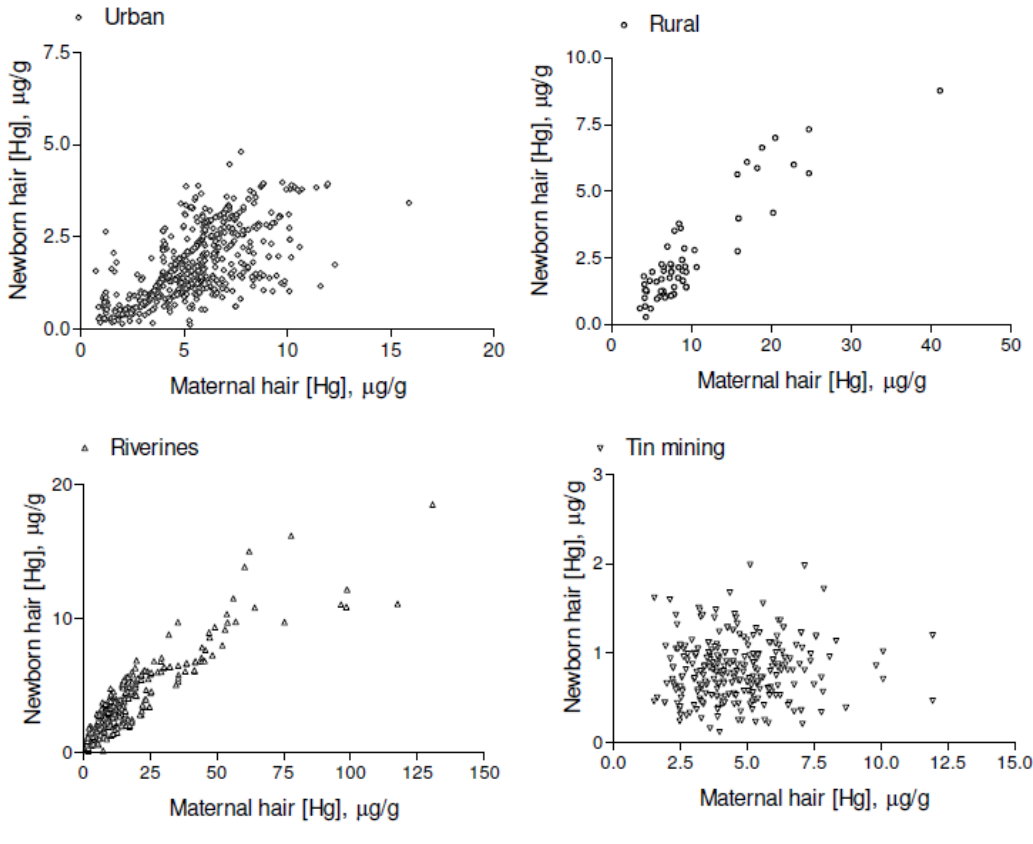
Figure 4. Scatter plots of total hair-Hg concentrations of mothers and respective newborns.